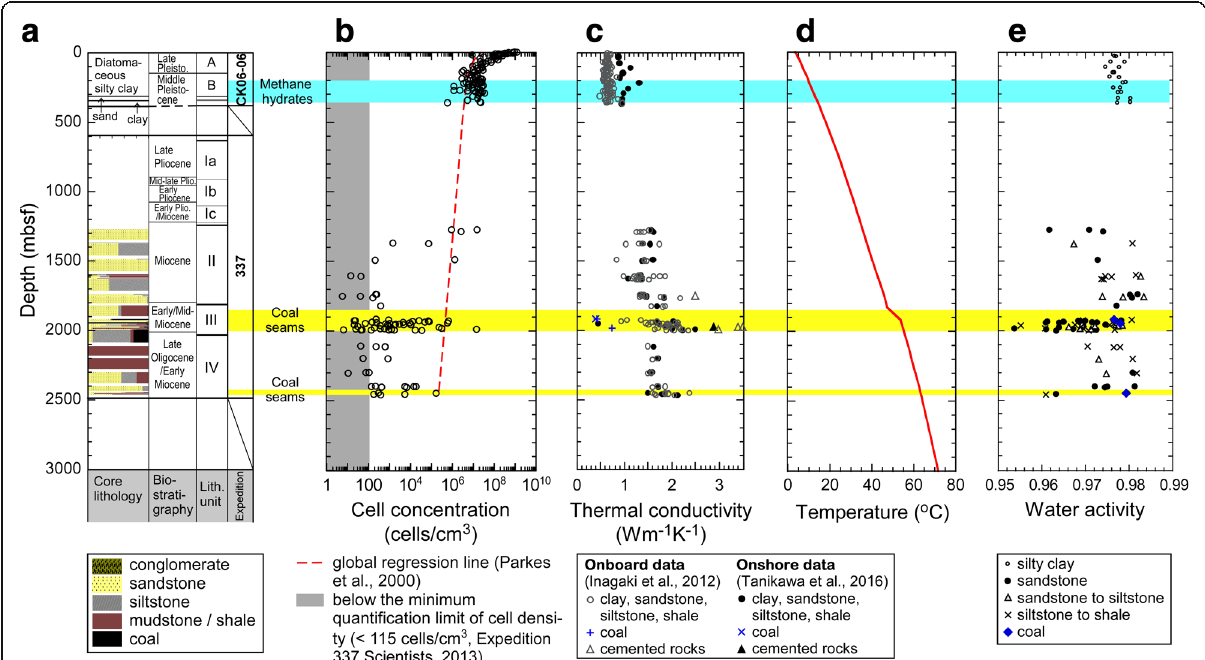
Fig. 2 a Core lithology, biostratigraphy, and lithological units at Site C0020 identified on Chikyu shakedown cruise CK06-06 and IODP Expedition 337, b cell concentration, c thermal conductivity, d predicted temperature profile, and e water activity at Site C0020. Figures are modified after Aoike (2007), Inagaki et al. (2012, 2015), and Tanikawa et al. (2018). Raw cell concentrations plotted in ( b ) were obtained from the microscopic counts reported by Inagaki et al.